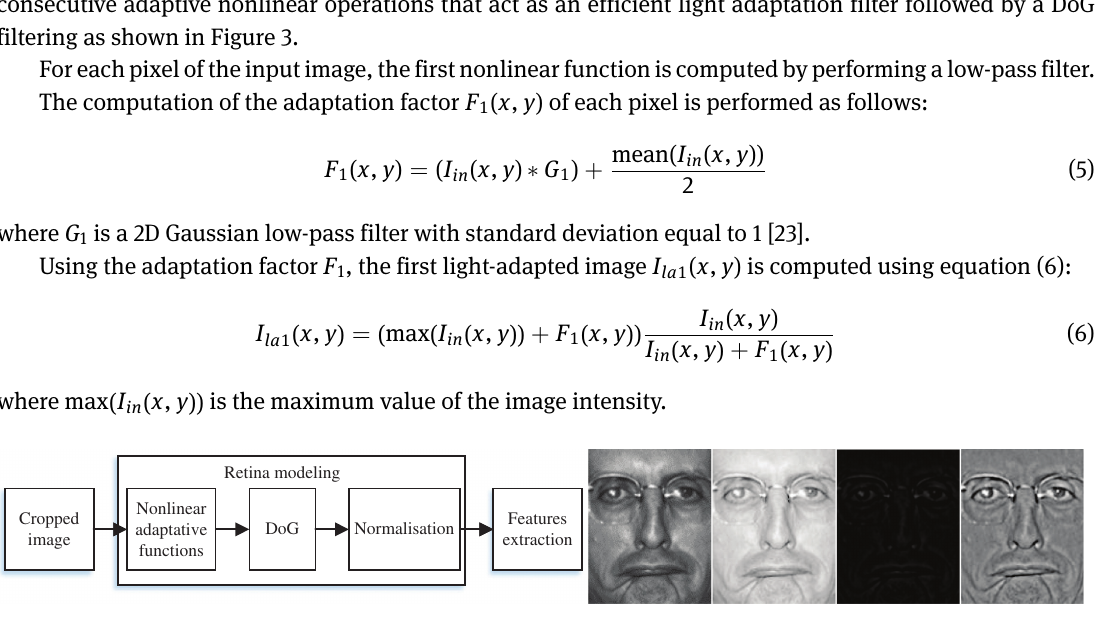
Figure 3: Retina